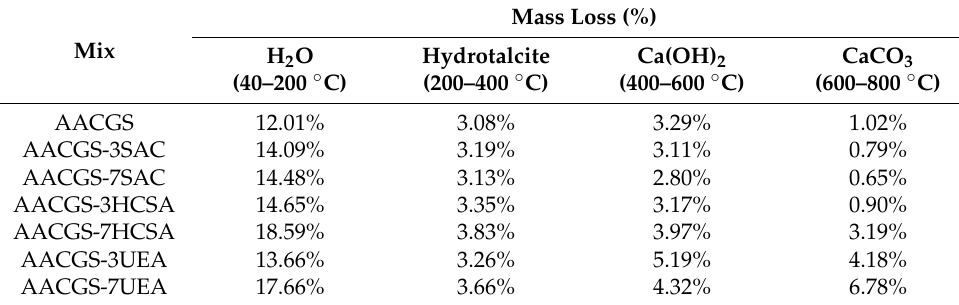
Figure 3. DTG curves of AACGS mixtures after 28 d of curing. ( a ) DTG diagram of AACGS with SAC, ( b ) DTG diagram of AACGS with UEA and ( c ) DTG diagram of AACGS with HCSA. Table 3. Weight loss between 40 ◦ C and 1000 ◦ C determined by